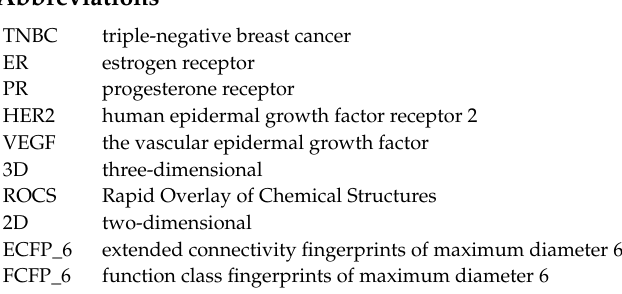
Figure S3: Inhibition rates of 12 compounds at 5 µ g/mL from C10 2D similarity search; Figure S4: Inhibition rates of 40 compounds at 5 µ g/mL from Compounds 2-5 and 2-8 2D similarity search; Table S1: Inhibition rates of analogs of 2-5 and 2-8 identified by 2D similarity search (Part